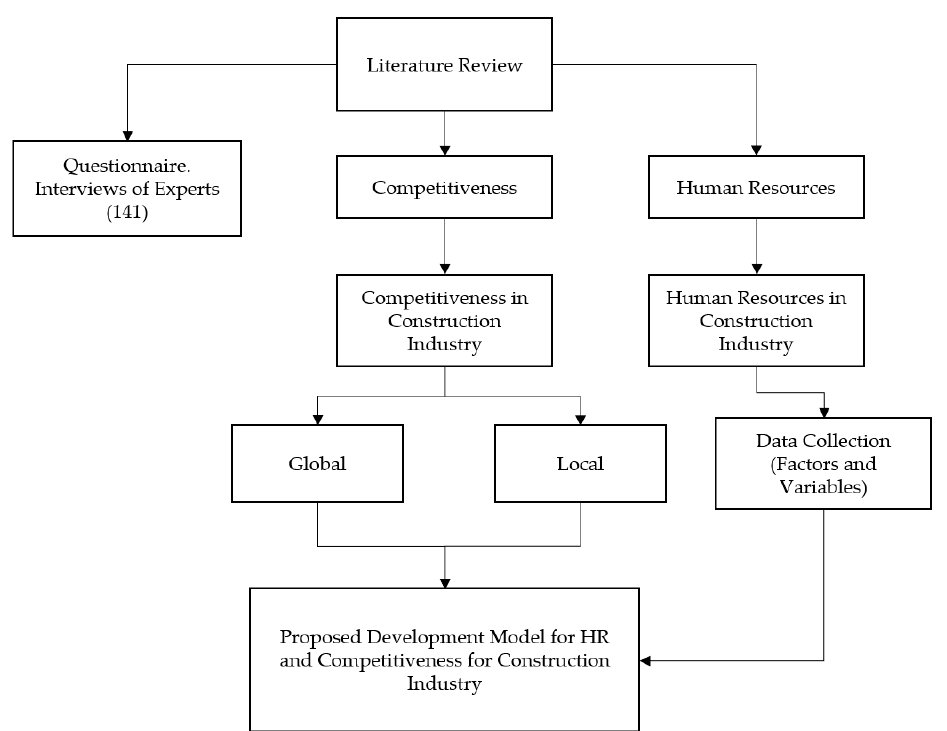
Figure 1. Methodology of the study.